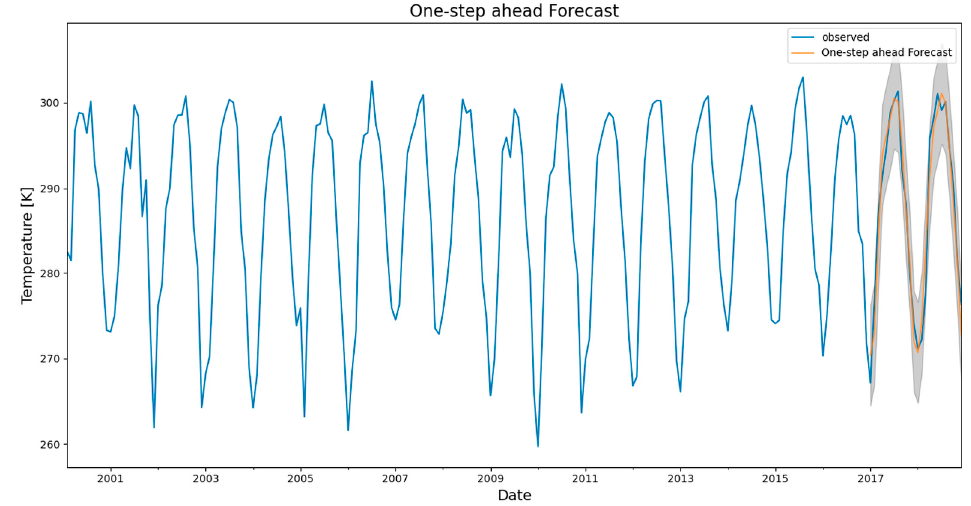
Figure 9. Diagnostic plots for the SARIMAX (1, 1, 1) × (0, 1, 1) 12 model. Top-left shows standardized residuals for SARIMAX, bottom-left presents quantile-quantile plot, top-right gives histogram and normal density plot and bottom-left gives correlogram.